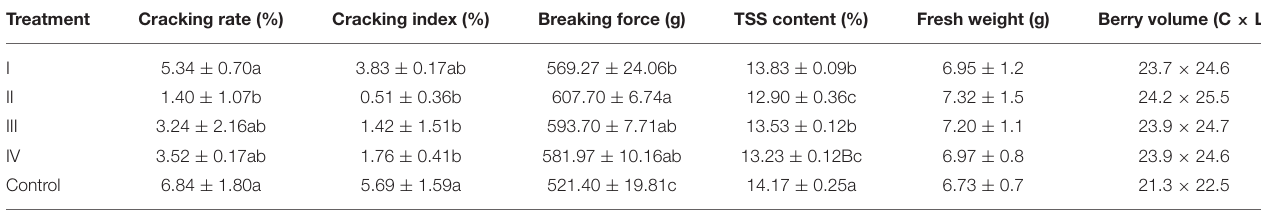
TABLE 2 | Effects of the CaCl 2 application on cracking, texture characteristics, and total soluble solids (TSS) content. Treatment